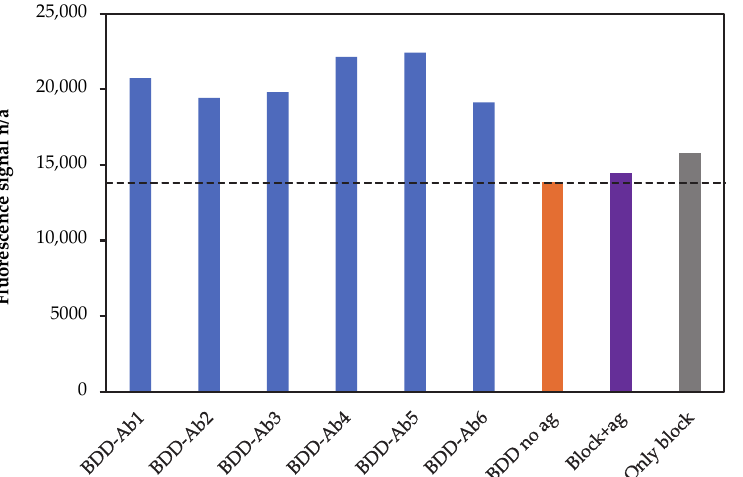
Figure 5. Fluorescence signal of the BDD electrodes after amino functionalisation, antibody immobilisation and incubation with fluorescently labelled human IgG-AF488 antigen; BDD-Ab1-6: six samples after antibody immobilisation, blocked and incubated with fluorescently labelled antigen. BDD no ag: after antibody immobilisation, blocked, without fluorescently labelled antigen (reference 1). Block + ag: no antibody immobilisation, blocked and incubated with fluorescently labelled antigen (reference 2). Only block: only blocked (reference 3). Dotted line represents background level due to auto-fluorescence of NH 2 -modified BDD electrodes. For full data including standard deviations,